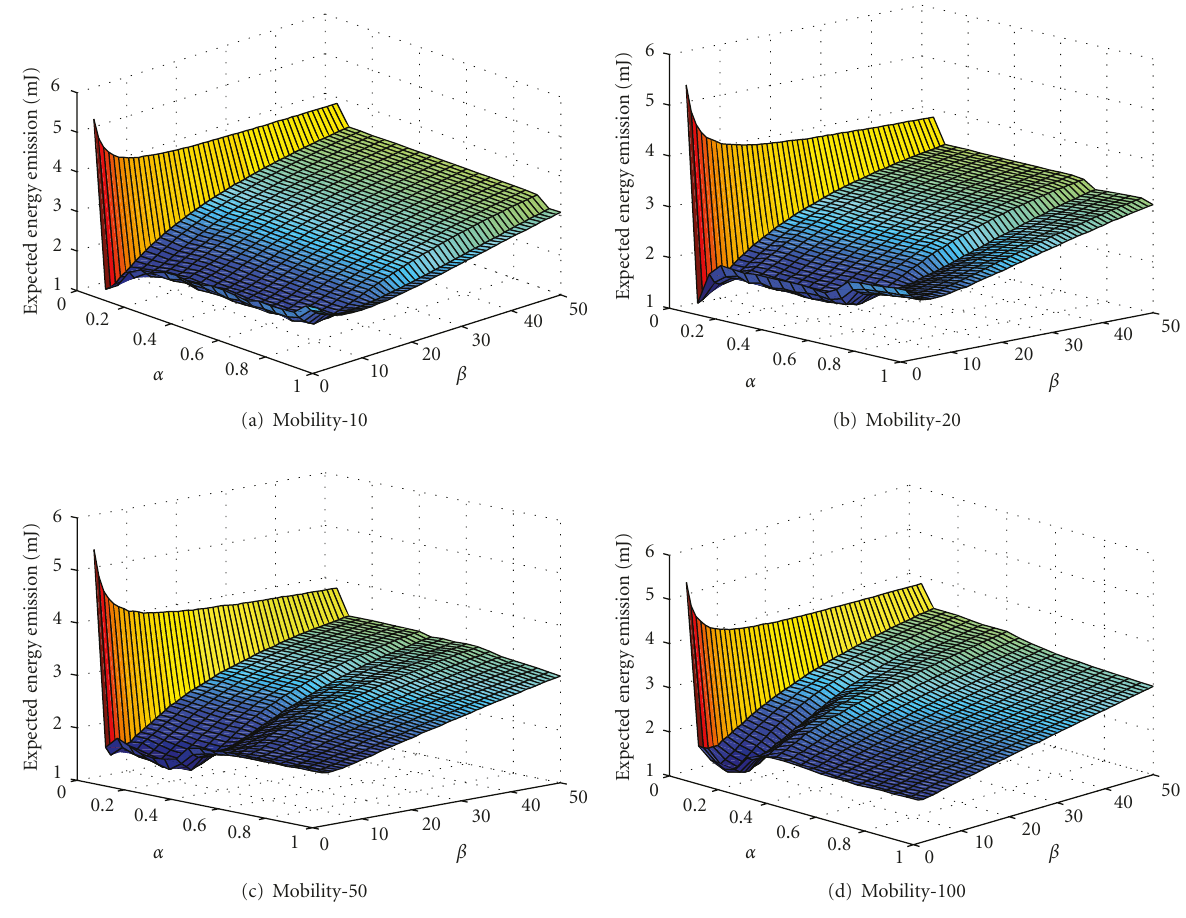
Figure 12: α and β combinations for di ff erent mobility levels.